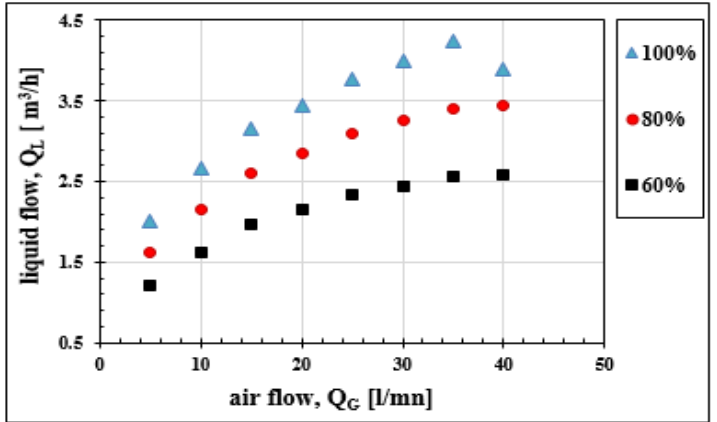
Figure 6. Effect of the clamping of the liquid flow on the pumping